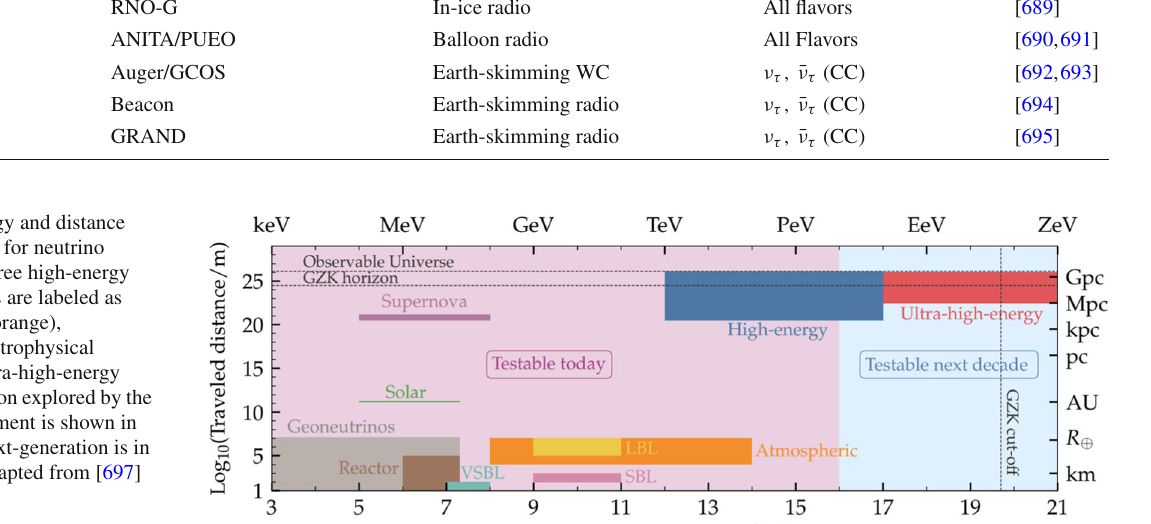
ple, DeepCore has an effective 10 Mton volume recorded over 300 , 000 neutrino events in the eight years run. Neutrino telescopes can use large sample sizes to study the ν μ disap- pearance and ν τ appearance channels to look for new physics through neutrino oscillations [410,778–781], and tank detec- tors use all channels however much smaller sample